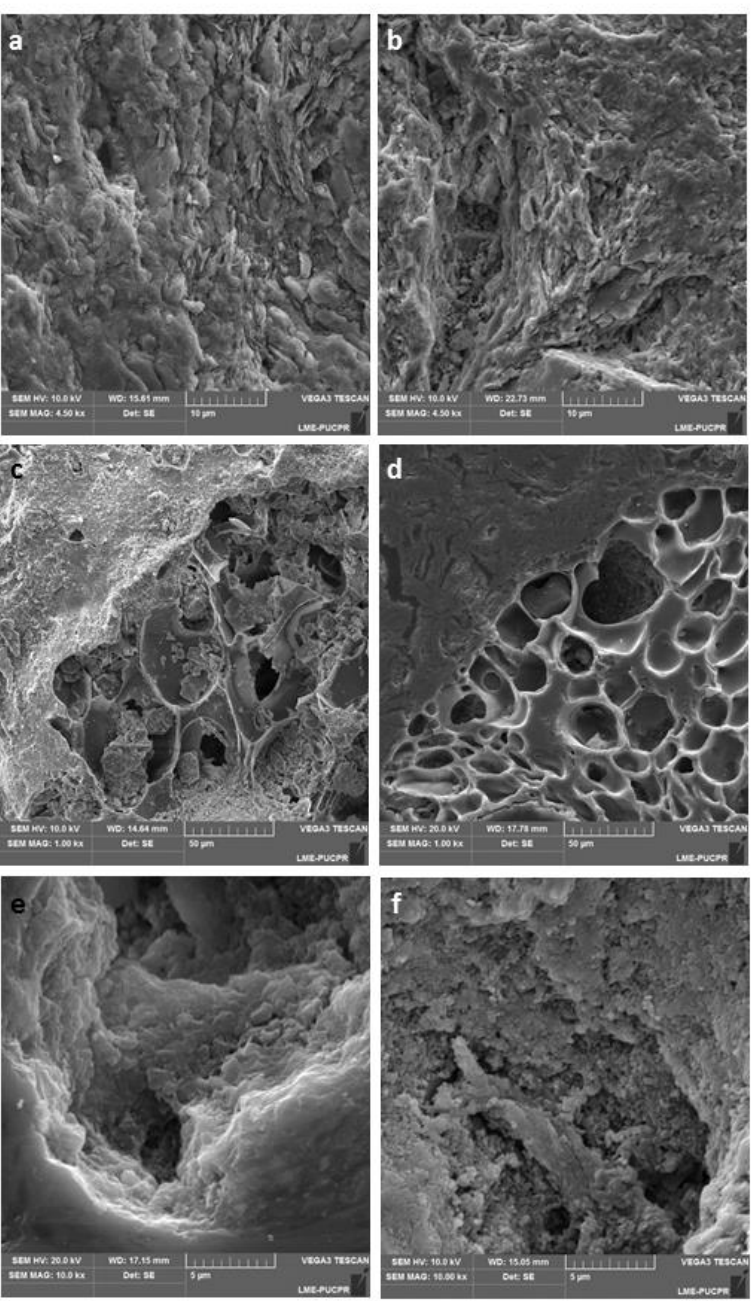
Figure 5. SEM images showing clay morphology at two different firing temperatures and 4500 × magnification ( a ) 800 °C and ( b ) 1000 °C. Composition of perlite and clay at a magnification of 1000 × : ( c ) 800 °C and ( d ) 1000 °C. Attapulgite with clay at a magnification of 10000 × : ( e ) 800 °C and ( f ) 1000